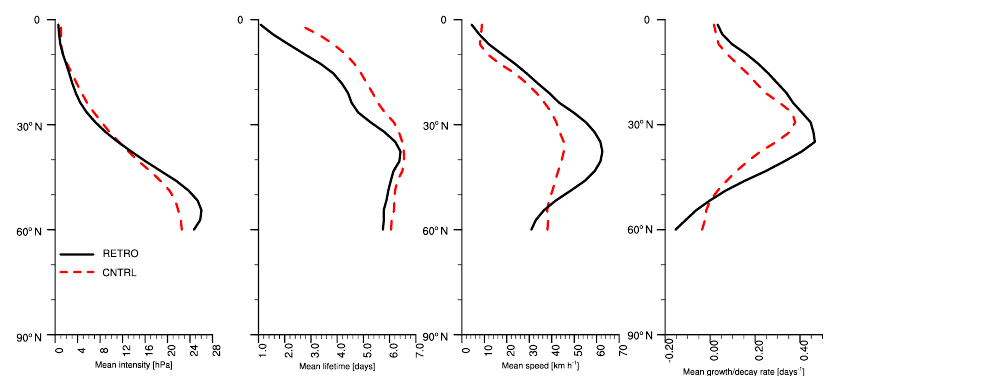
Figure E3. Zonal averaged statistics obtained from the tracking algorithm for the JJA season in the Southern Hemisphere Pacific Ocean